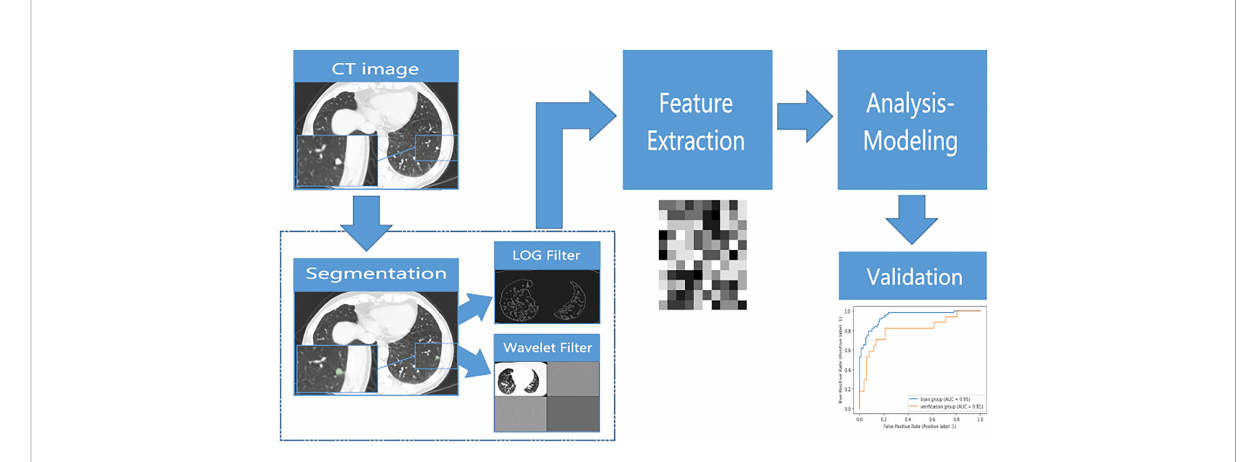
FIGURE 2 The fl ow chart of radiomic feature extraction and model